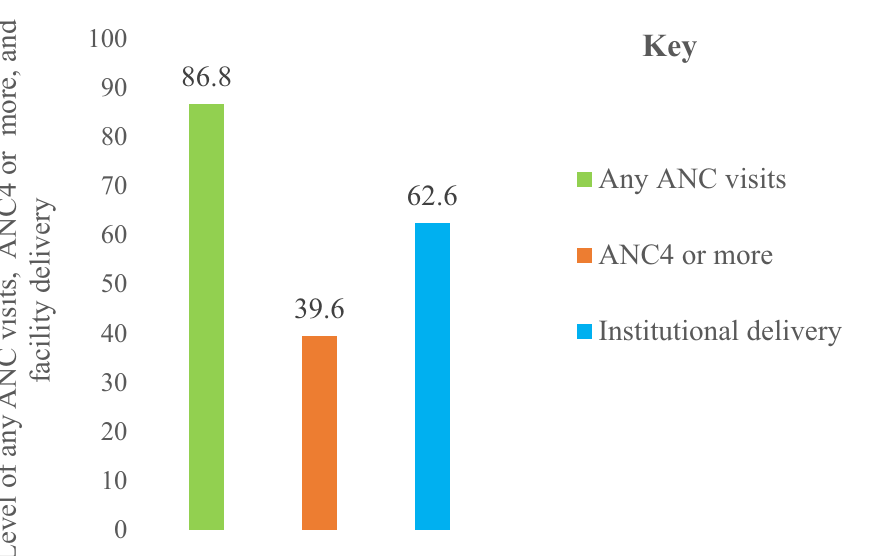
Figure 1. Any ANC visits, ANC4 or more, and institutional delivery in Northwest Ethiopia,